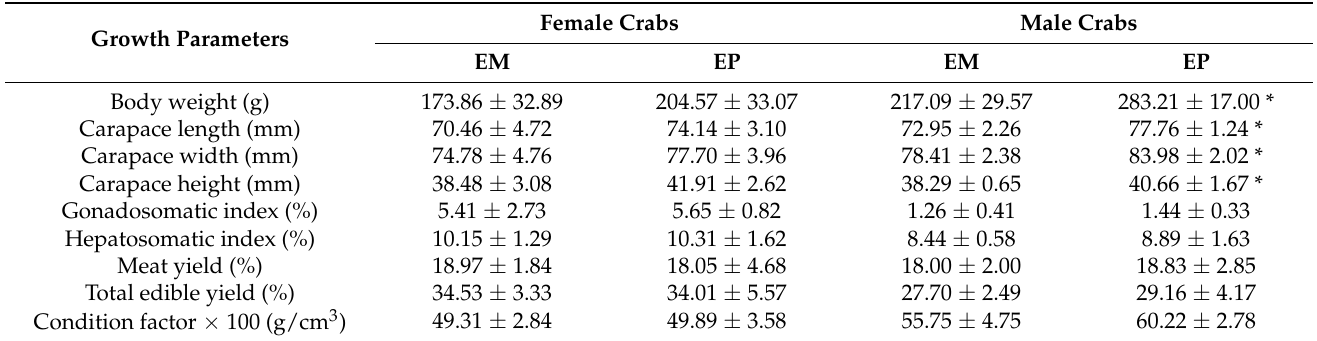
Table 2. Growth parameters of Chinese mitten crabs reared in the EM and EP groups from T1 to T4. Values are means ± SD ( n =